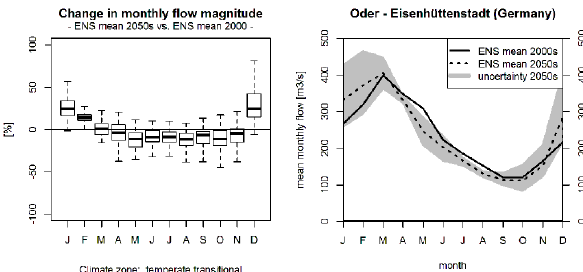
Fig. 11. Direction of change in the 2050s plotted for all grid cells of the temperate transitional climate zone (left) and the Oder river near Eisenh¨uttenstadt (right).